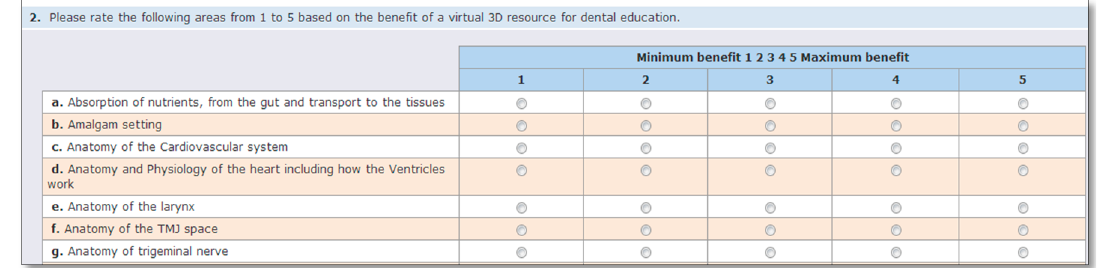
Figure 1. Extract of the survey.